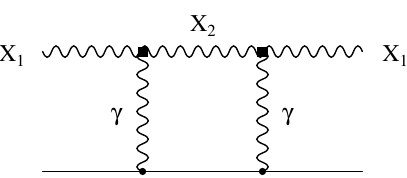
Figure 3 . Graph contributing to the elastic scattering X 1 + f → X 1 + f off fermions such as electrons or nuclei in the target. The boxes are insertions of the dimension-six